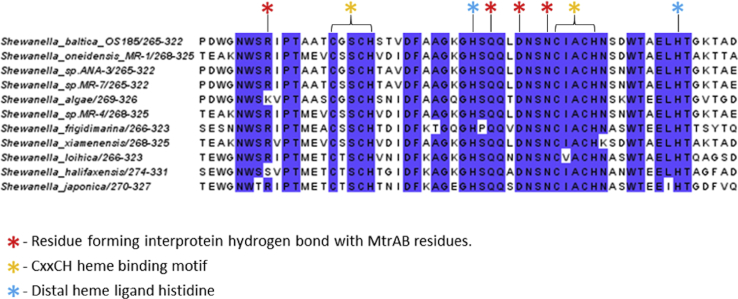
Sequence Alignment of Amino Acids of MtrC, which Form an Interface with MtrA Based upon the Structure of MtrCAB from Shewanella baltica OS185, Related to Figure 5MtrC sequences were aligned with Clustal Omega (Sievers and Higgins, 2018)and formatted with Jalview (Waterhouse et al., 2009).